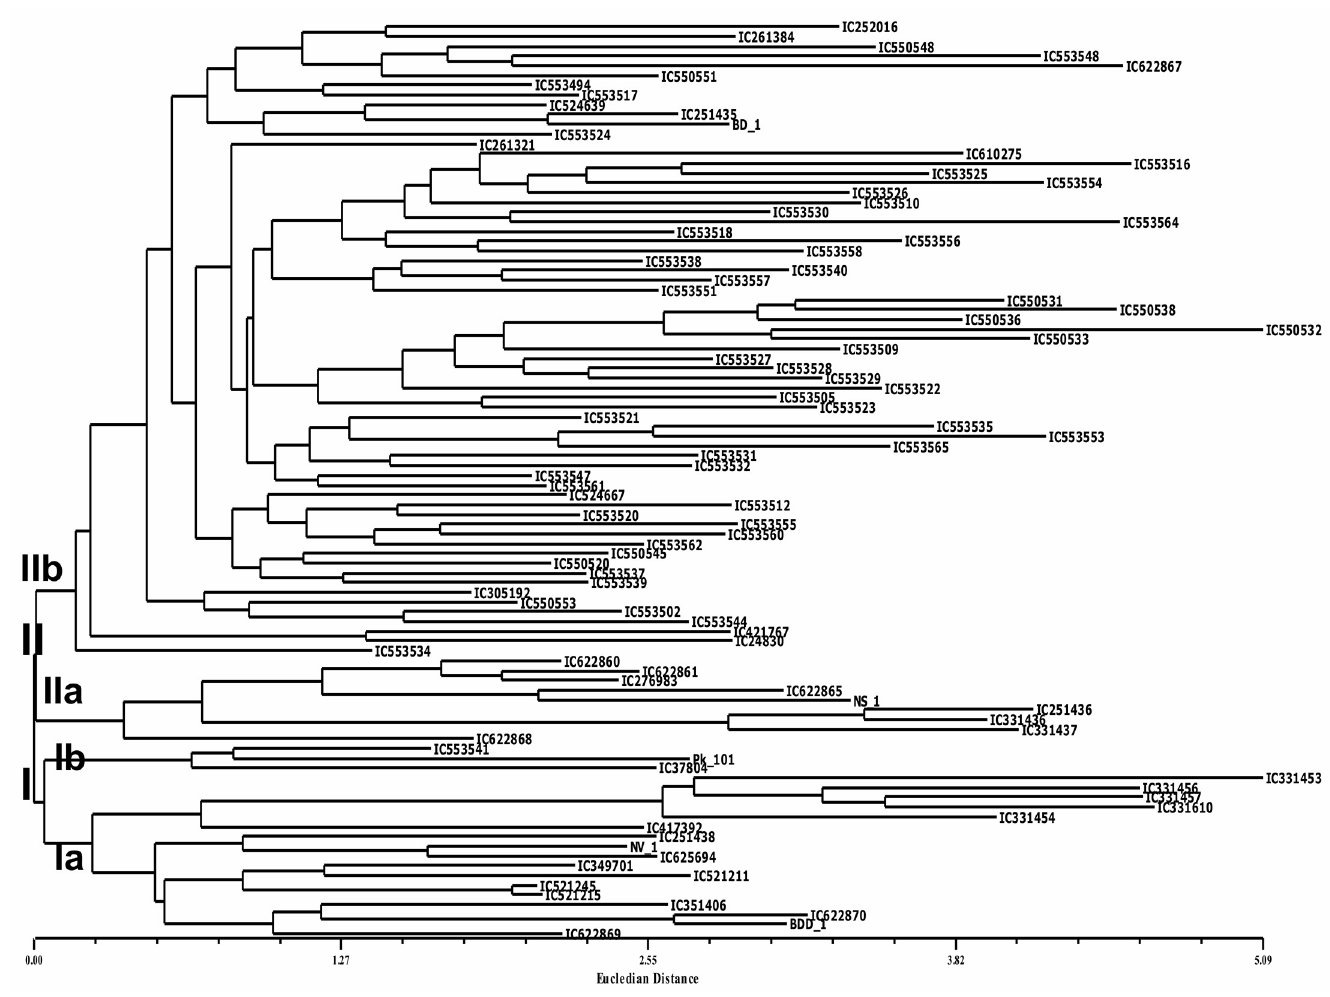
Fig 2. Dendrogram based on Euclidian distance using NJ tree method of clustering depicting genetic diversity and relationship between 94 accessions of V . stipulacea as revealed by quantitative